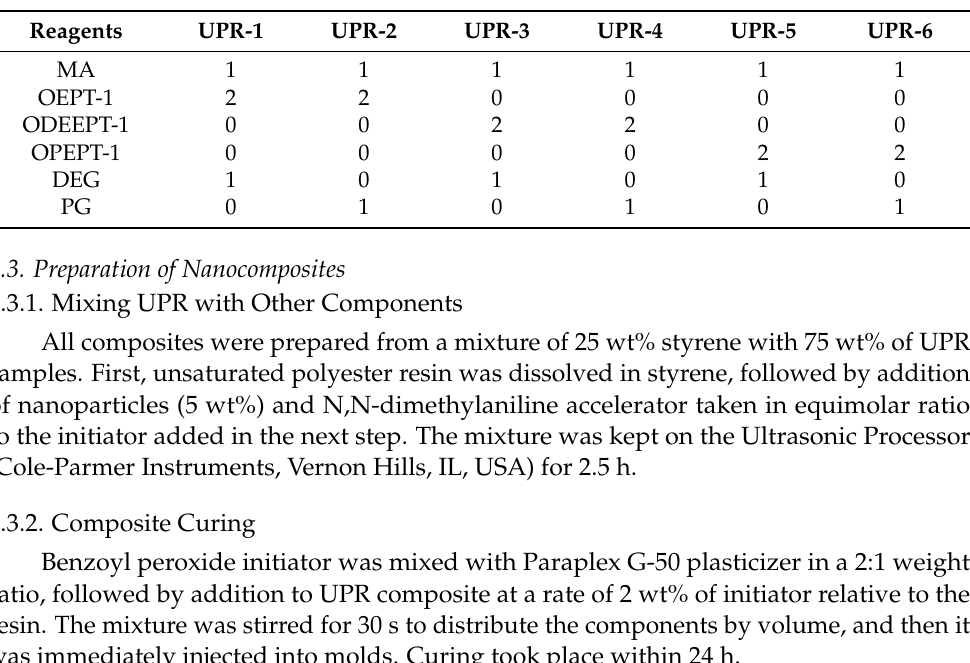
Table 2. Molar ratios of UPR-(1–6) samples synthesis